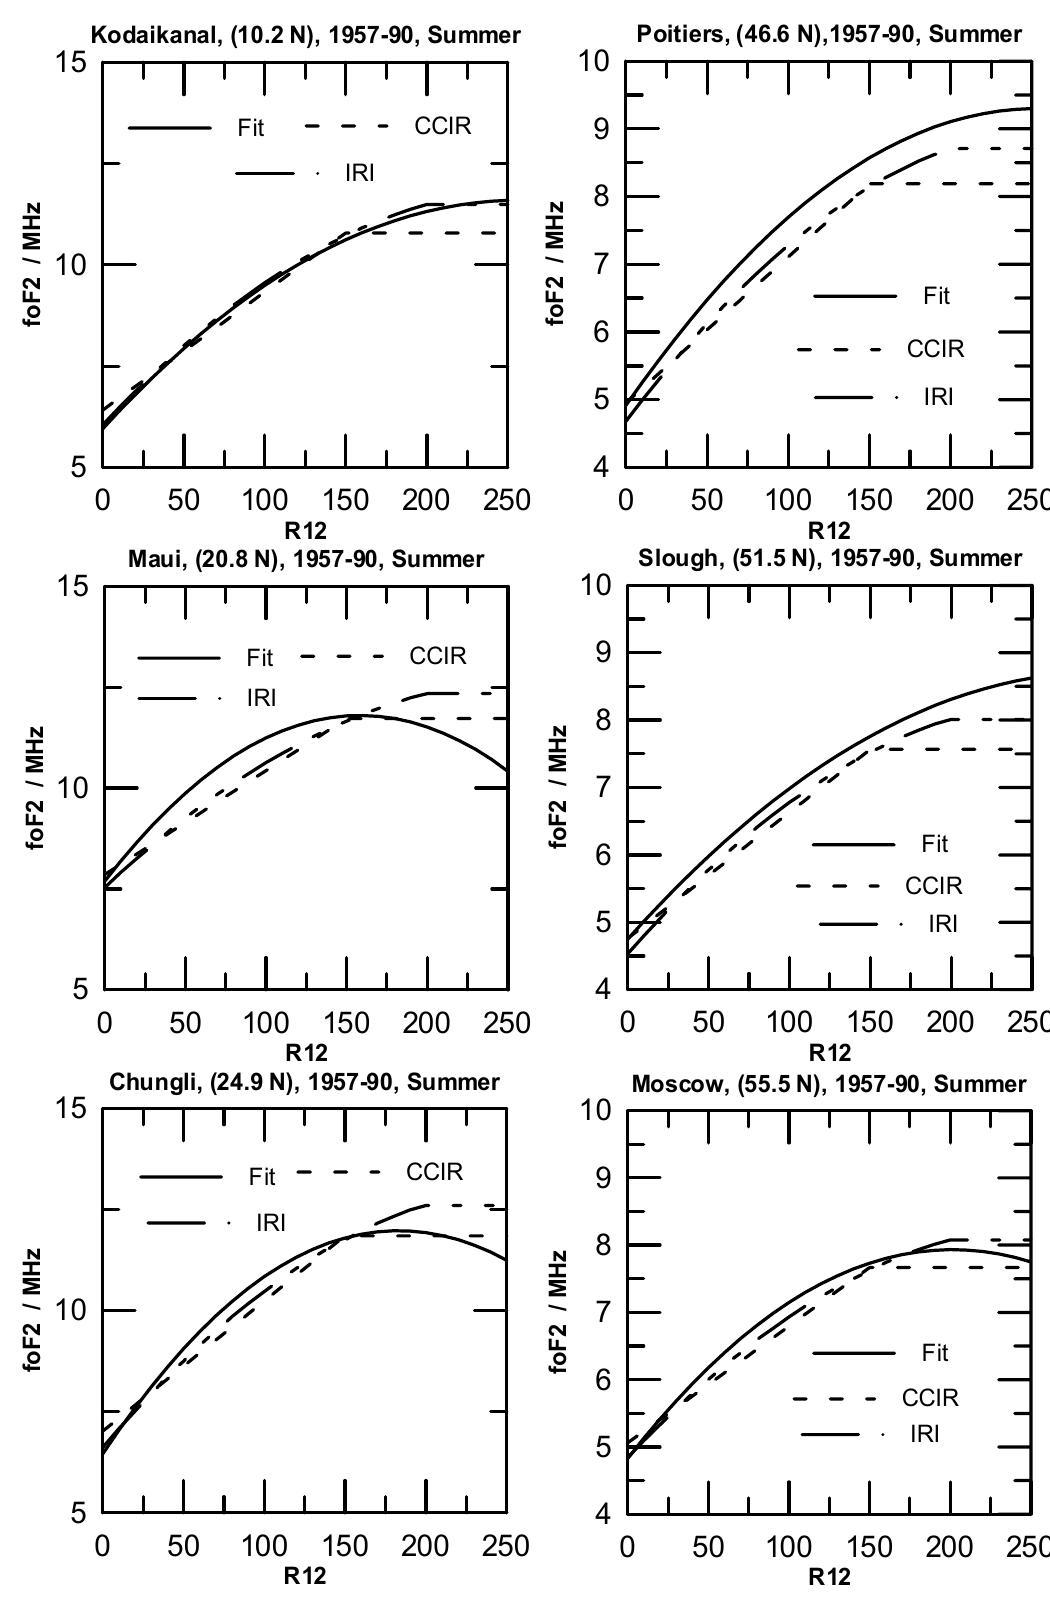
Fig. 4. Shows the variation of regressions fits with R12 along with the CCIR and IRI models for summer. Low- and mid-latitude stations are shown on left and right panels of the